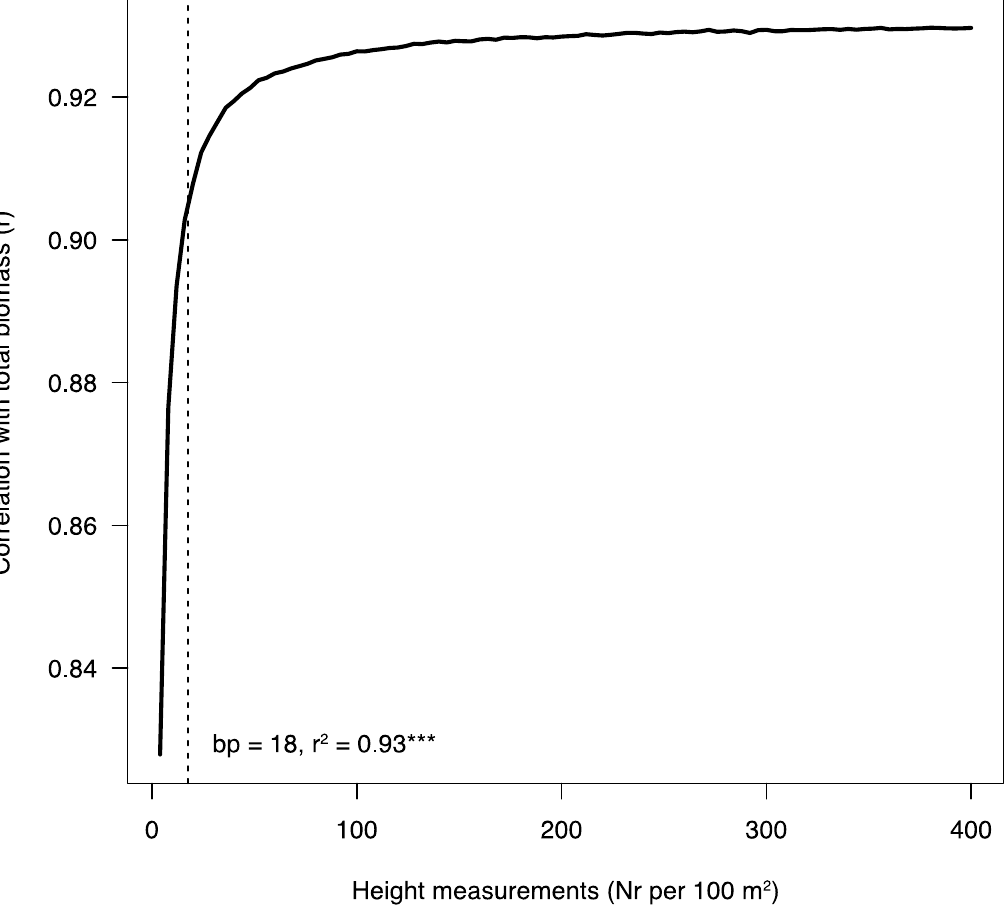
Figure 3. Correlation of the number of height measurements per 100 m 2 with total biomass. Using segmented regression after testing for a change in slope with Davies’ test ( p < 0.05), the point was estimated at 18. Nr = number; bp = breakpoint, *** = p < 0.001.